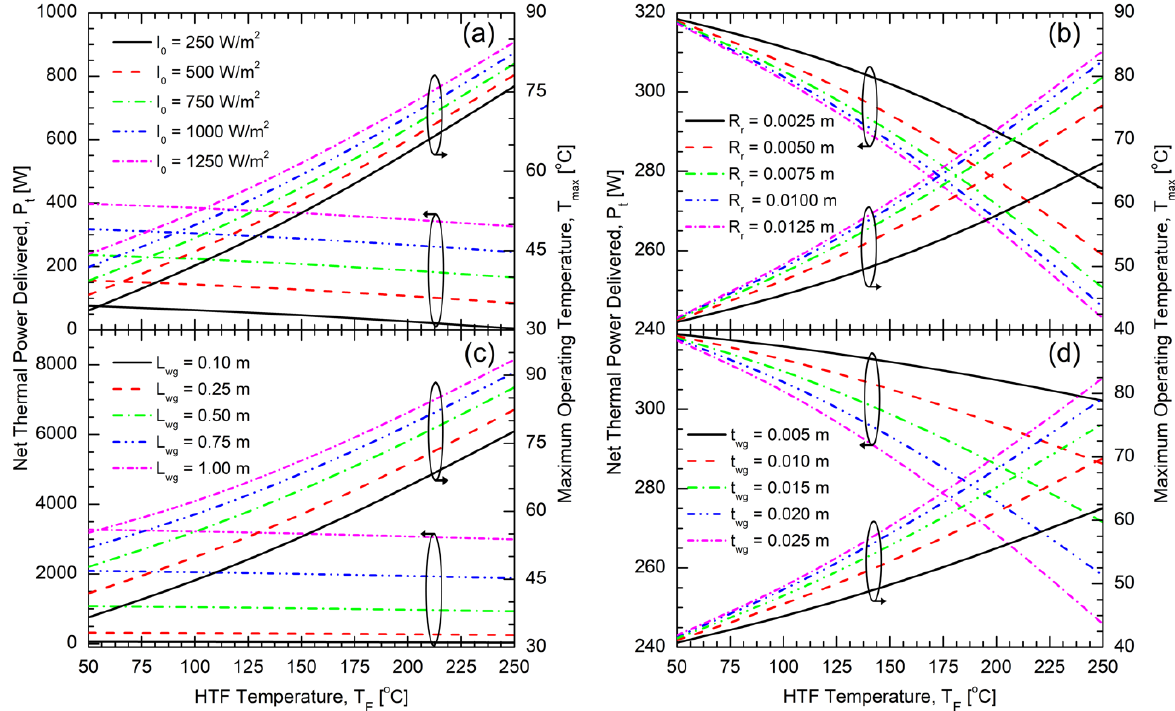
Figure 4. Influence of ( a ) Incident solar radiation ( I 0 ), ( b ) receiver radius ( R r ), ( c ) waveguide length ( L wg ), and ( d ) waveguide thickness ( t wg ) on net thermal power delivered ( P t ) and maximum operating temperature ( T max